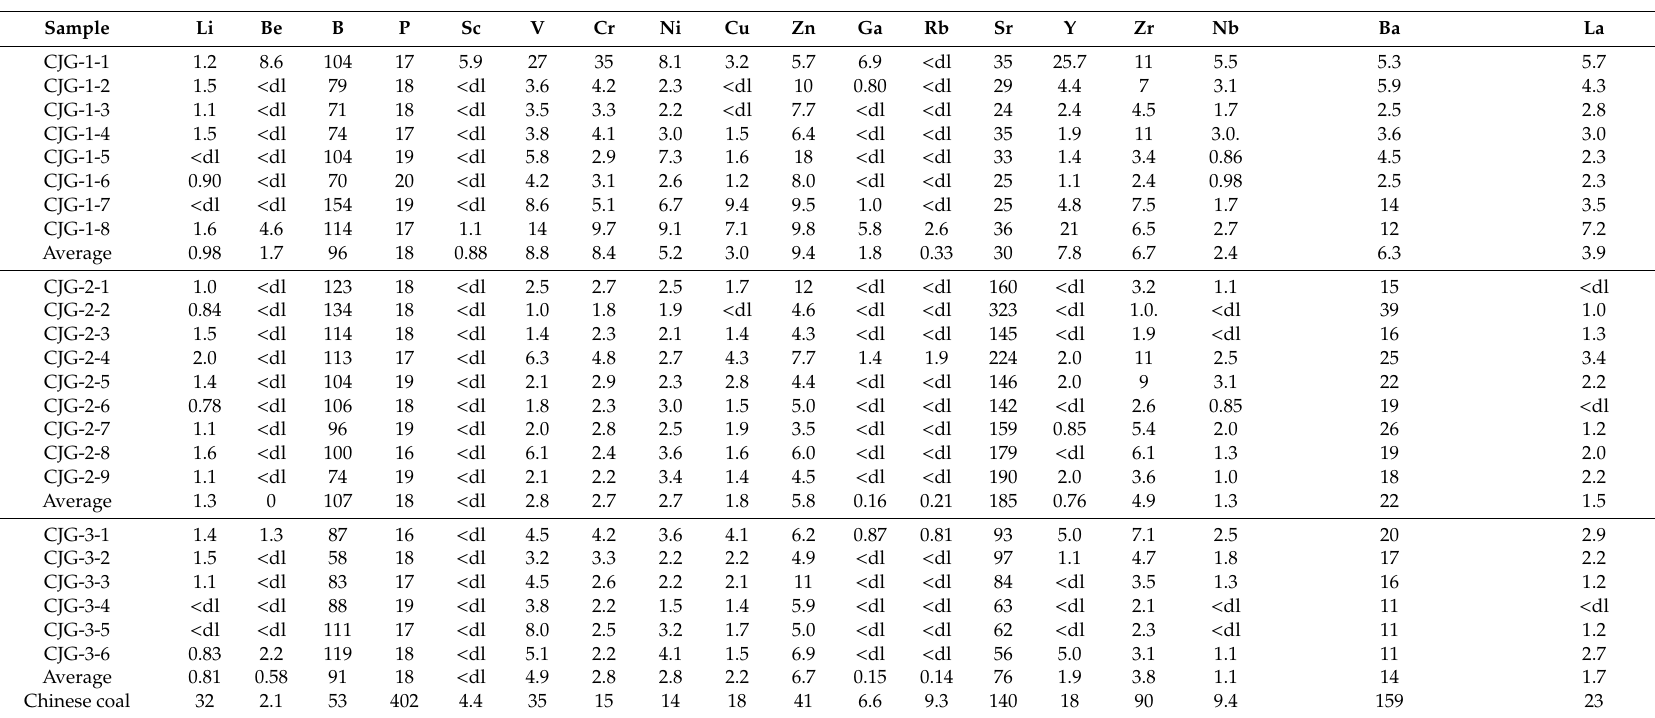
Table 4. Trace elements concentrations ( µ g / g, db) in coals and non-coals from the two coal mines (on whole-coal basis). Average concentrations of Chinese coal date from Dai et al.,